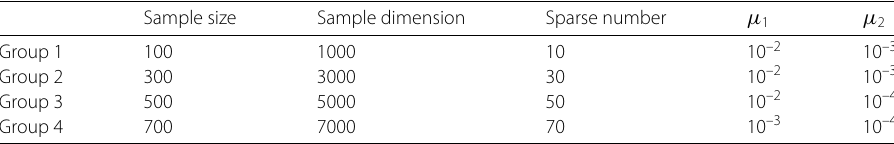
Table 1 The description of optimization problems and corresponding regularized parameters Sample size